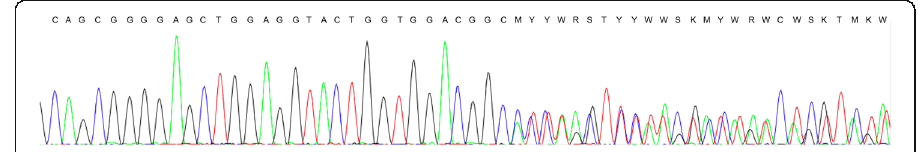
Fig. 3 gDNA direct sequencing for the mother of affected child using Sanger sequencing method. Chromatogram is showing the frameshift